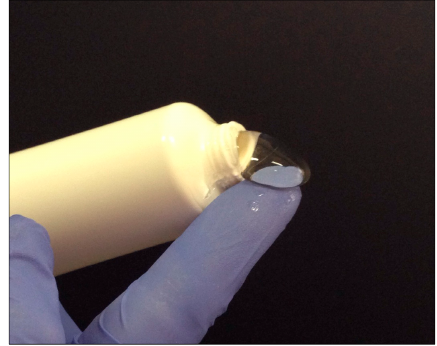
Figure 1. Chitosan gel formulation used in the study.